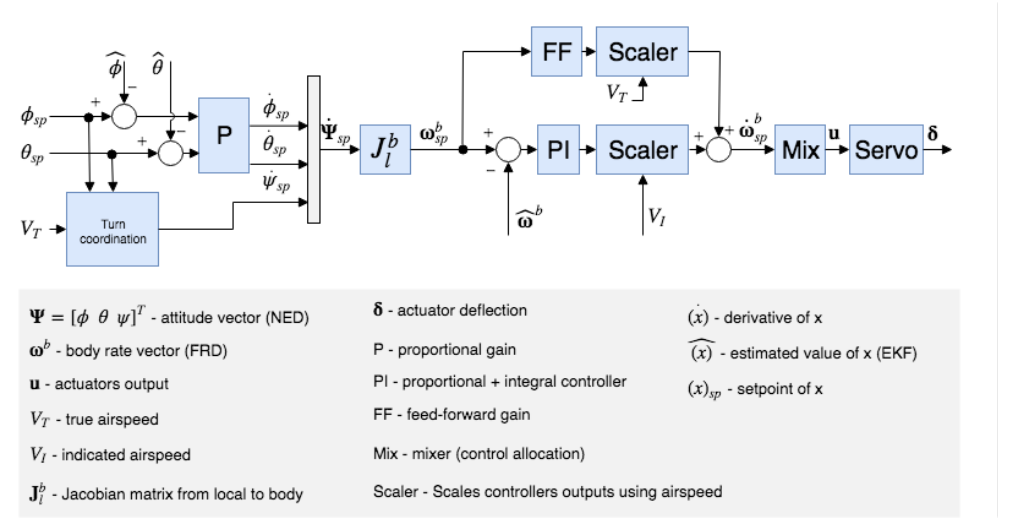
Figure 12. Attitude control loop for fixed-wing UAVs in